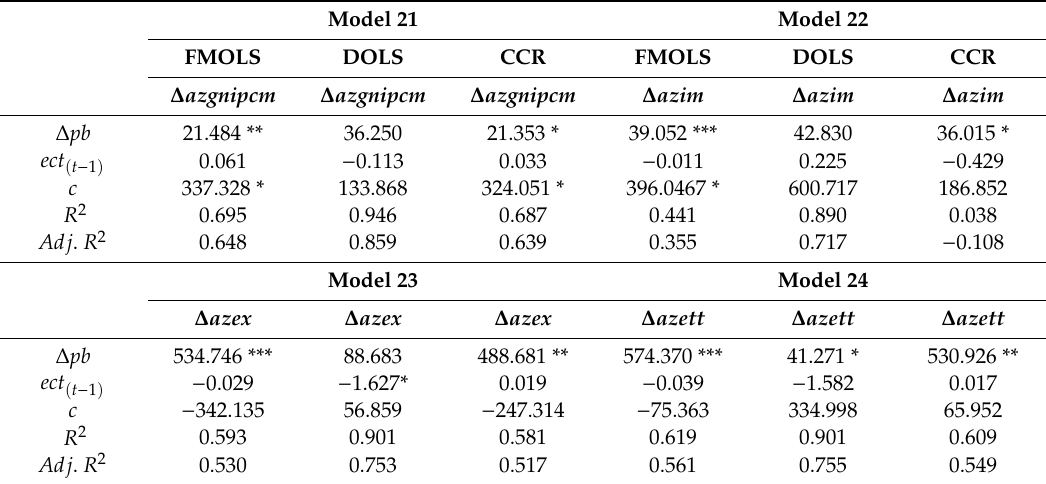
Table 13. The influence of oil price on macroeconomic indicators (Azerbaijan).